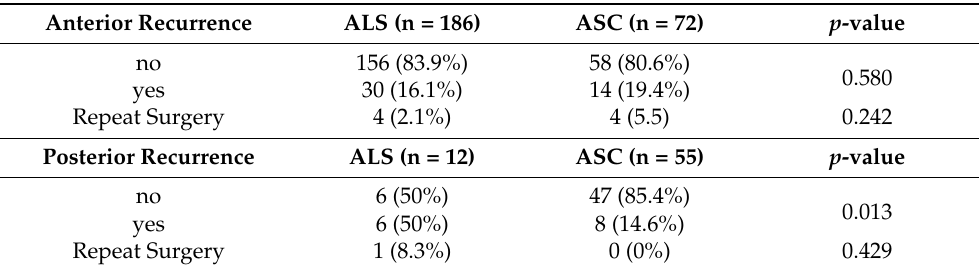
Table 5. Anatomical outcomes in the anterior and posterior compartment based on clinical evalu- ation with a simplified POP-Q measurement as defined by IUGA-ICS prolapse staging. Data are presented as frequency (%). Simplified POP-Q values comparing ALS vs. ASC before surgery and after surgery were statistically analyzed with two-tailed Fisher’s exact test. p -values < 0.05 were considered statistically significant. POP-Q: Pelvic Organ Prolapse Quantification System; IUGA- ICS: International Urogynecological Association—International Continence Society; ALS: